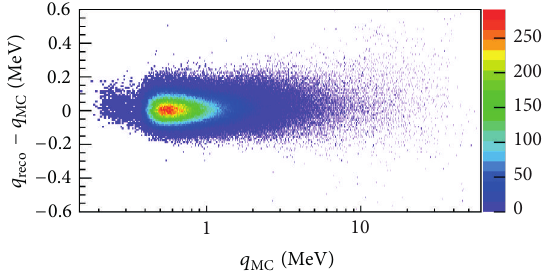
Figure 4: Simulation: the absolute difference between the recon- ) and the simulated hit energy structed hit energy deposit ( 𝑞 reco ) as a function of 𝑞 . The hits shown are originating deposit ( 𝑞 MC MC from muon tracks simulated with isotropic initial direction. The tail < 0.4 MeV corresponds to the hits of the distribution with 𝑞 MC at track end points, only partially crossing the distance between consecutive wires. The peak of the distribution corresponds to the hits of minimum ionizing particles; the points at high values of 𝑞 Figure 5: Fit optimization diagram. The inner loop contains the hit MC come from low energy, highly ionizing parts of tracks. assignment to nodes and segments of the fit ( projection step) and the optimization of node 3D positions. New nodes are introduced to the fit in the outer loop until the 𝐾 max number of nodes is